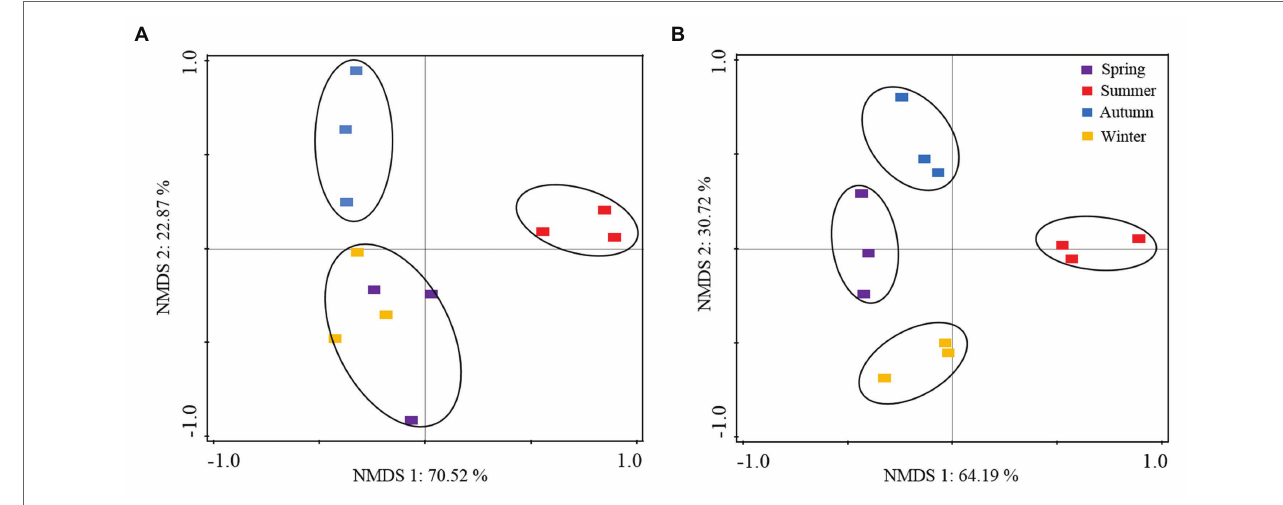
FIGURE 5 | Nonmetric multidimensional scaling (NMDS) plots of the fungal community variation in P. tabuliformis forests based on the relative read abundance of operational taxonomic units (OTUs). (A) Root fungal community; (B) rhizospheric soil fungal community. Samples from seasons are indicated with distinct colors; fungal lifestyles in the community are indicated with distinct